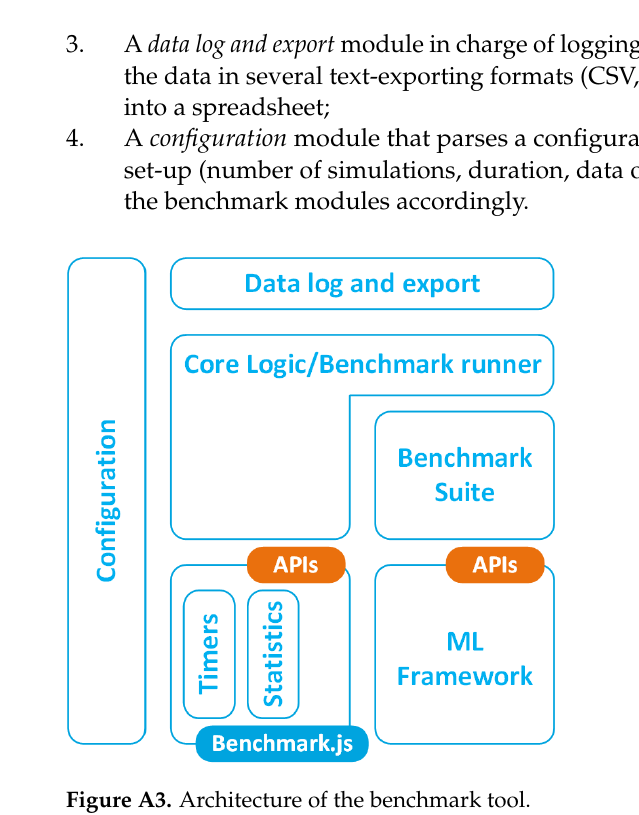
Figure A3. Architecture of the benchmark